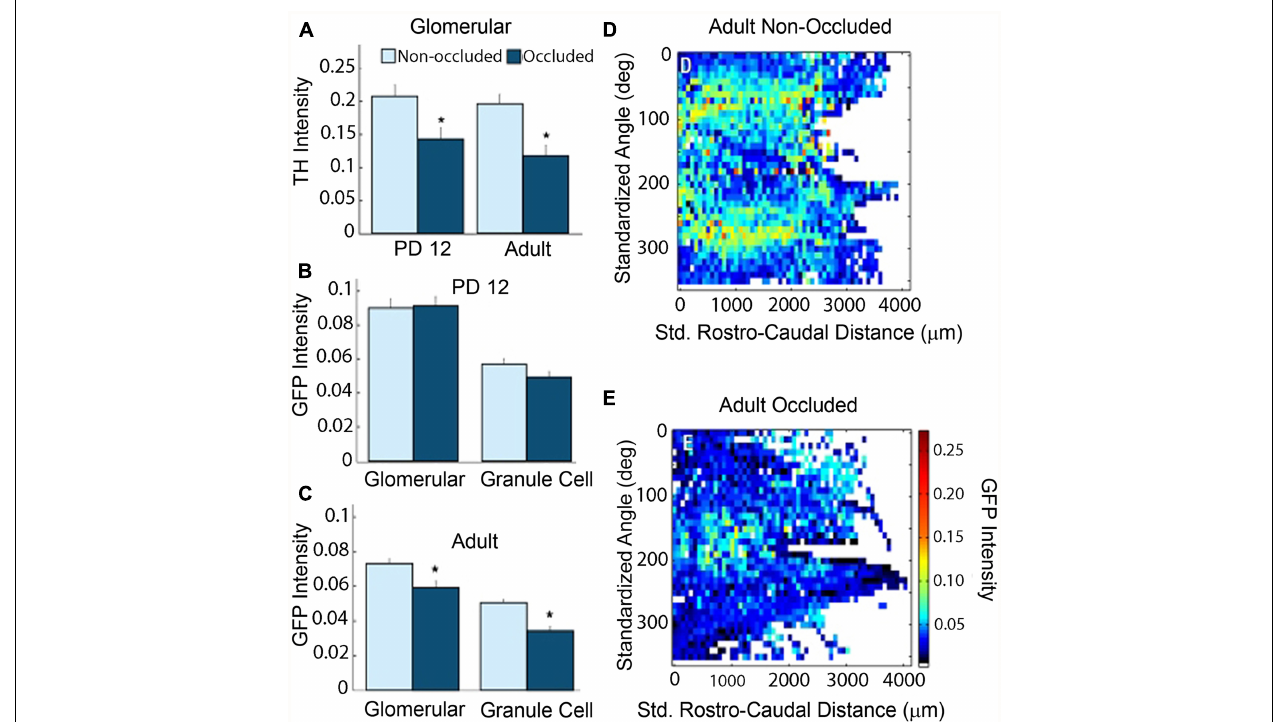
FIGURE 3 | Naris occlusion abolishes differential GFP staining pattern in adult animals. Background subtracted intensities from 12-bit images were converted to a 0–1 scale and plotted. Details of image processing are given in Salcedo etal. (2011). (A) Significantly lower tyrosine hydroxylase (TH) intensity in occluded bulbs as compared to non-occluded bulbs confirmed that the occluded bulbs had reduced olfactory activity in both PD12 animals and adult animals ( t -test, p -value = 1 × 10 − 2 and 3.6 × 10 − 4 , respectively). (B) PD12 animals: mean GFP intensity did not